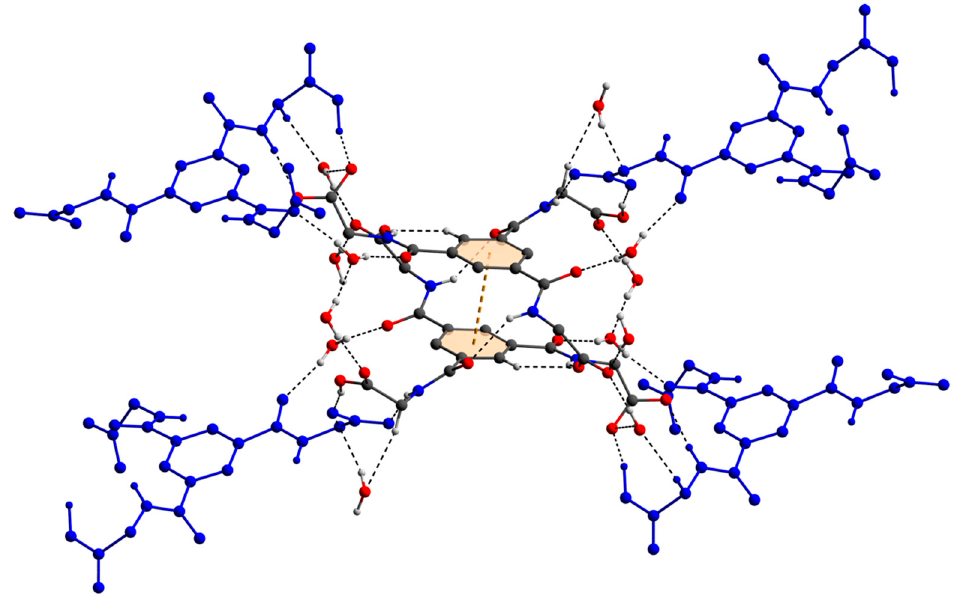
Figure 1. The molecular entities of the zinc(II) complex and the dianion as well as water molecules with atom labels and displacement ellipsoids of non-H atoms drawn at the 40% probability level. The hydrogen atoms of the carbons have been omi tt ed for clarity (see Tables S1 and S2 for details).